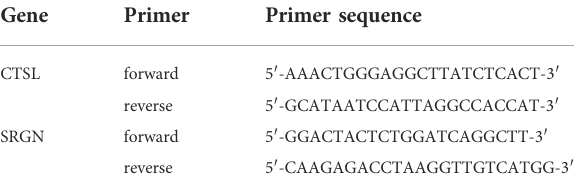
TABLE 1 Sequences for CTSL siRNA and SRGN siRNA. TABLE 2 Primers for CTSL and